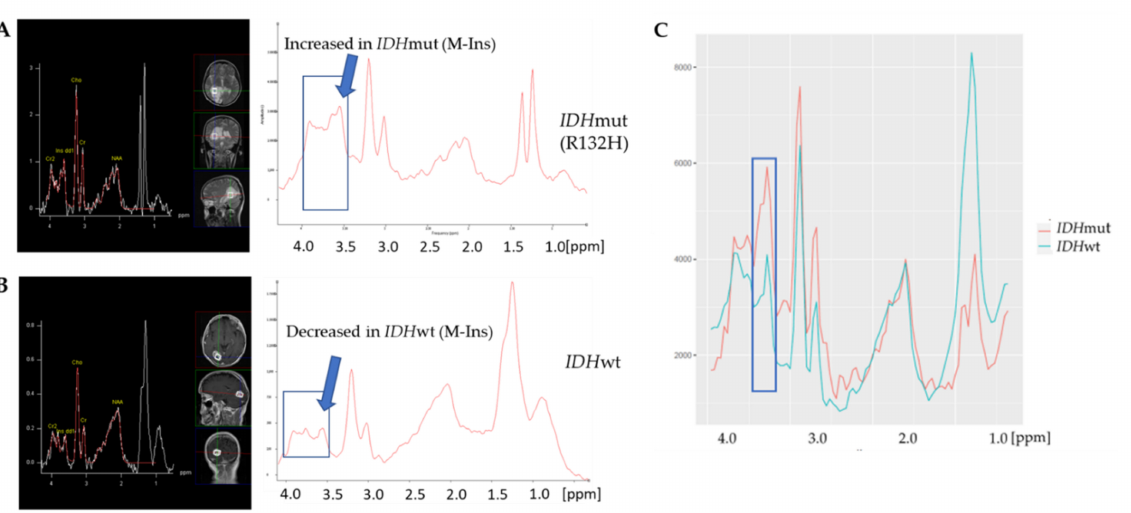
Figure 3. 1 H-MR spectra obtained for an IDH mut patient with R132H mutation ( A ) and an IDH wt patient ( B ) of the validation cohort. ( C ) Averaged spectra of IDH mut group (marked in red, n = 23) and of IDH wt group (marked in green, n = 44) of the validation cohort. The region used for classification including M-Ins peak is indicated by the blue box. 1 H-MR: 1 H-magnetic resonance; IDH : isocitrate dehydrogenase ; mut: mutated; wt: wildtype; M-Ins: myo-inositol.